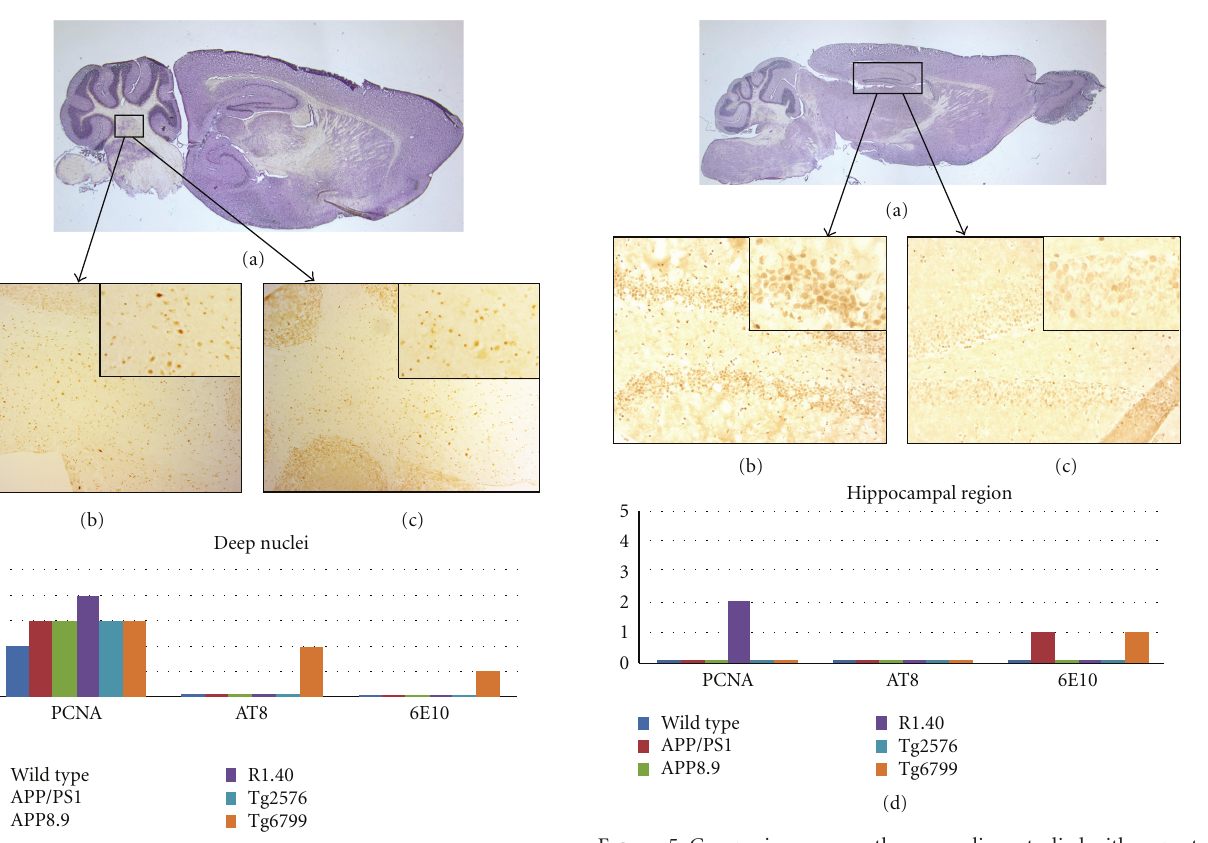
Figure 5: Comparison among the mouse lines studied with respect to the presence of cell cycle events (PCNA), tau-phosphorylation (AT8), and beta-amyloid plaque deposition (6E10) in the hippo- campus. (a) Sagittal section of a wild-type mouse brain indicating the approximate location of the areas illustrated in (b) and (c). (b) PCNA-positive neurons are illustrated by their appearance in this representative section from the R1.40 mouse model. Note the involvement of a subset of the dentate granule cells as well as a few CA4 pyramidal neurons (arrows). (c) Minor PCNA immun- ostaining is seen in wild-type mice. The insets in panels (b) and (c) represent higher magnification of the CA2 region of their respective mouse model. (d) Quantification of the extent of immunostaining for the cell cycle, phospho-tau, and beta-amyloid plaques in the five transgenic models plus wild type. Note that only the R1.40 model showed cell cycle protein expression at the ages we